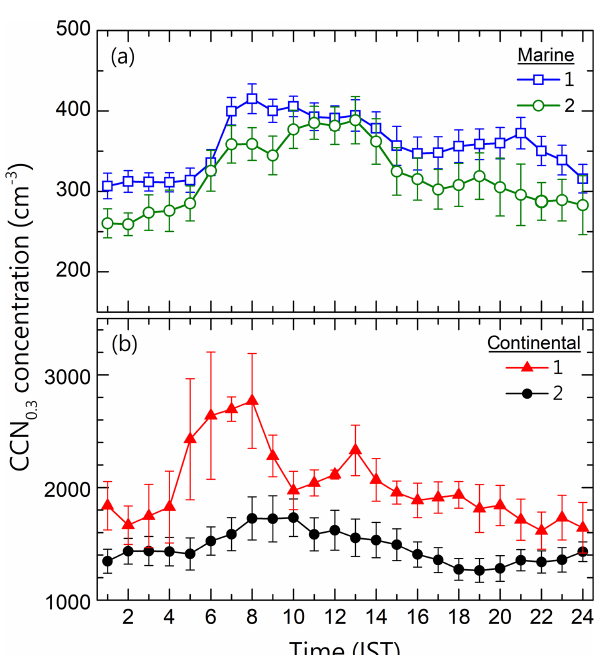
Figure 5. Diurnal variation of CCN concentrations at 0.3% SS dur- ing (a) marine and (b) continental conditions.